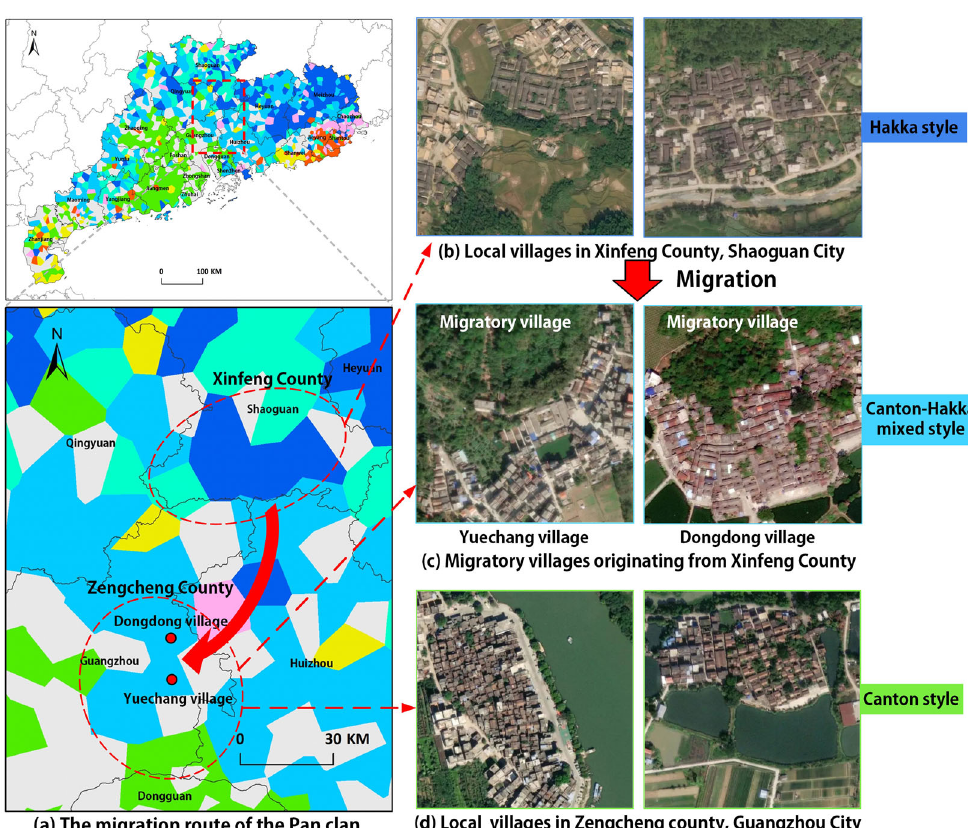
Fig. 9 The migration route of the Pan clan and the village layouts shown in the satellite images. a The migration route of the Pan clan (the red arrow) is drawn based on the historical records of the Pan Ancestral Hall. b The local villages at the start of the migration route (Xinfeng County, Shaoguan City) show Hakka style in the satellite imagery. d The local villages at the end of the migration route (Zengcheng County, Guangzhou City)are Canton style in the satellite imagery. And ( c ) the migratory villages show Canton-Hakka mixed style in the satellite imagery.